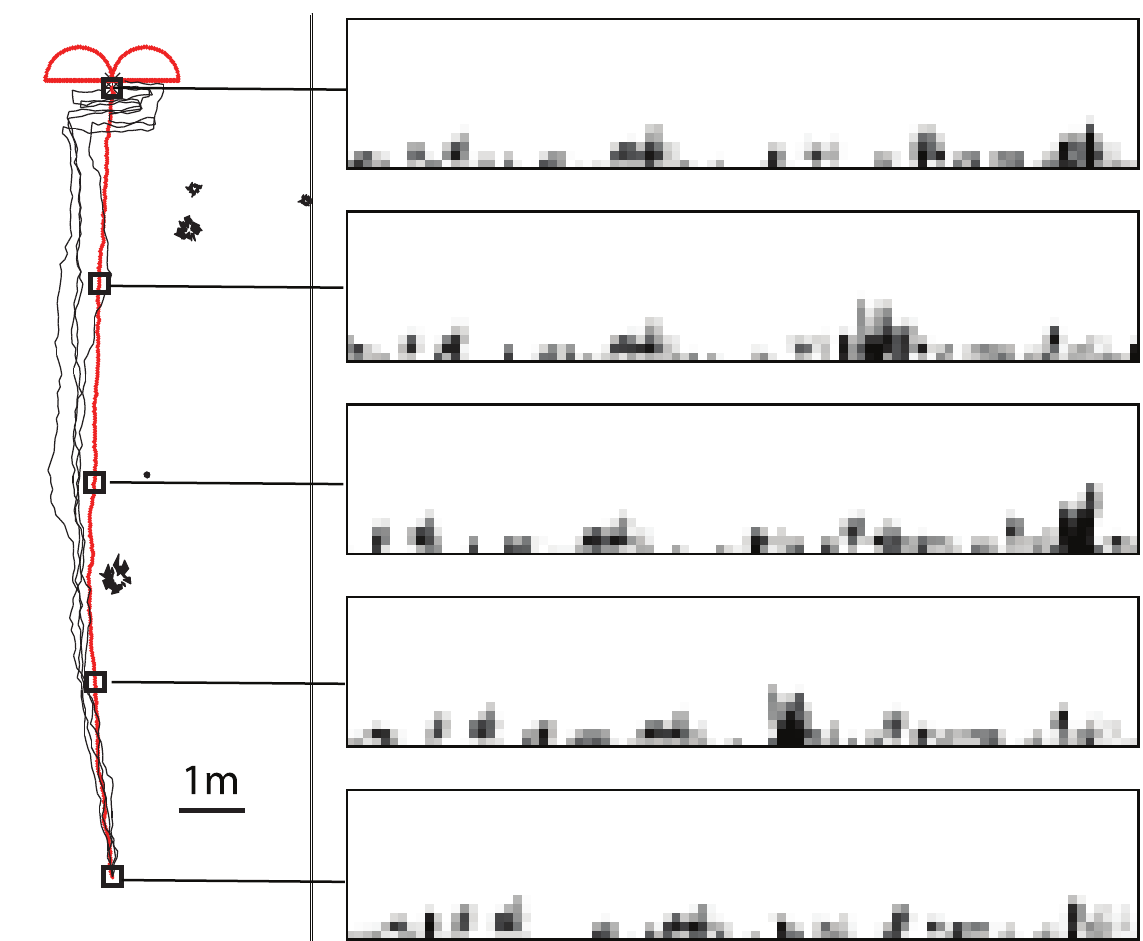
Figure 4. Navigational performance in a sparse environment with a tussock density of 0.05 tussocks = m 2 . The left panel shows the training (red) and test (black) paths for a 12 m route. The right panel shows example views from points (indicated by squares) from the training route. The combined learning walk and training route consisted of 520 views that were used to train the network.